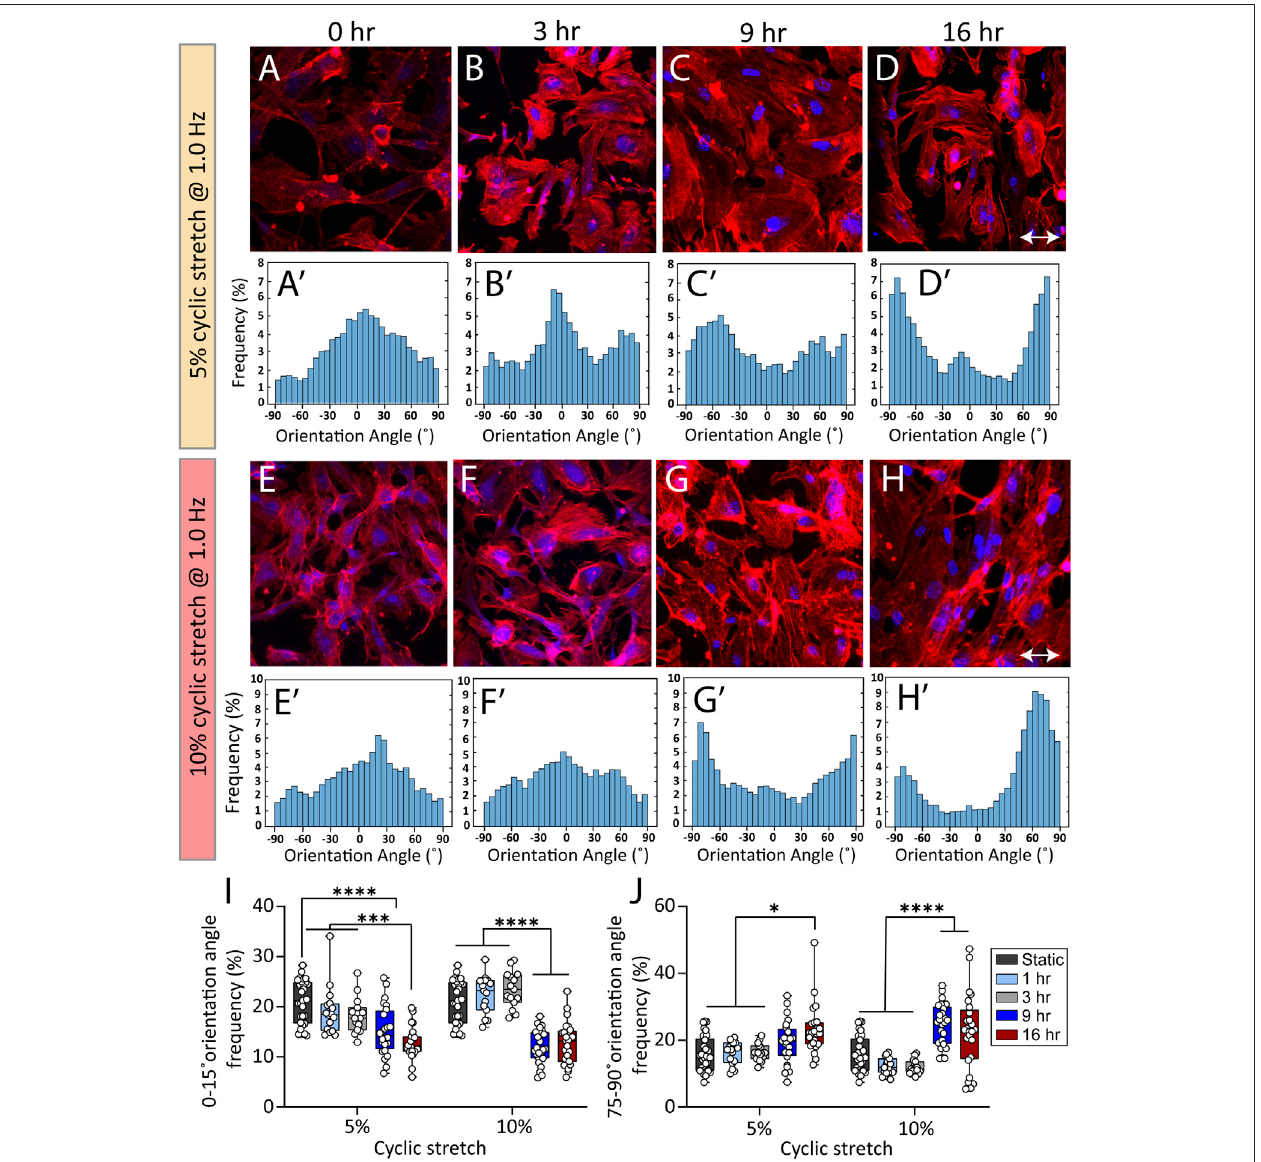
FIGURE 3| Cyclic stretch controls the orientation of stress fi bers in HAECs. (A – H) Immuno fl uorescent images ofactin stress fi bers in HAECs cultured under static and cyclic stretch conditions under cyclic stretch levels of 5 and 10%. Actin is labelled with Atto 565-phalloidin (red) and the nucleus is labelled with DAPI (blue). Double- headedarrowsindicatethestretchdirection. (A ʹ – H ʹ ) Histogramsshowingthefrequencyofstress fi bresorientationangleatdifferentstretchlevelsandexposureperiods. (I,J) SummarygraphscomparingthefrequencyofHAECsstress fi breswithorientation anglesof (I) 0 – 15 ° and (J) 75 ° – 90 ° whensubjectedtocyclicstretchlevelsof 5 and 10% under various exposure periods. Circles represent single cells. Boxes show median and fi rst and third quartiles. * p < 0.05, *** p < 0.001, **** p < 0.0001, two- way ANOVA and Tukey ’ s multiple comparisons test. Cyclic stretch controls the morphology of endothelial cells and the cell nucleus.